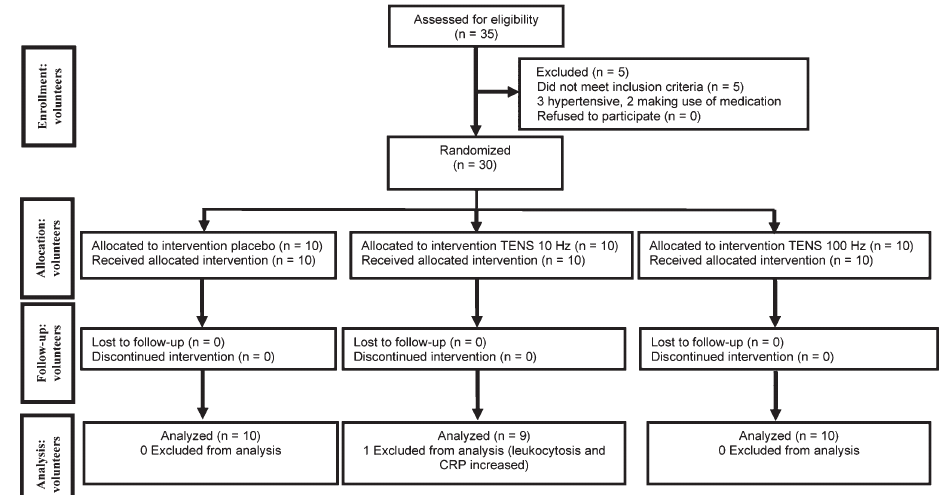
Figure 1. Flowchart of the volunteers in the